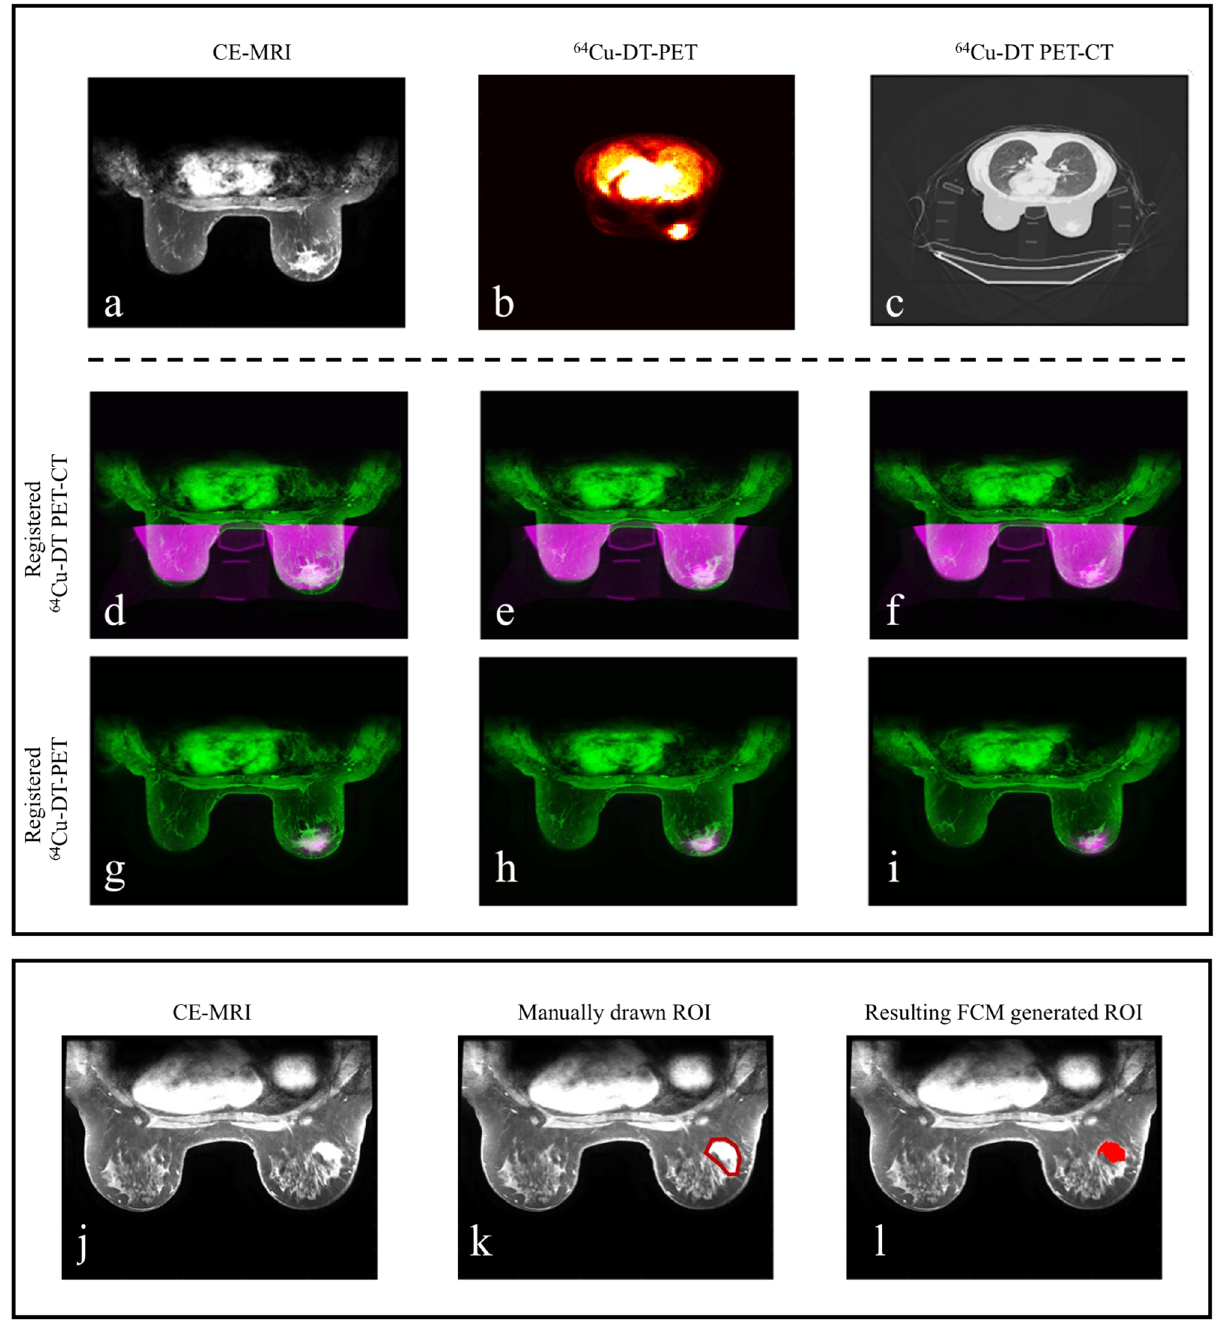
Figure 3. Example images of data processing for intra-scan registration of PET data to MRI data (upper panel) and generation of tumor ROIs (lower panel). Upper panel, deformable intra-scan registration for PET data to MRI data. Note that these images were all acquired in the prone position as opposed to the usual supine position using our novel breast support device (see text for details). The top row depicts a central slice for patient 1 at baseline for the CE-MRI ( a ), 64 Cu-DT-PET ( b ), and the 64 Cu-DT PET-CT ( c ). After the CT data is trimmed to only include breast tissue (i.e., the chest cavity and breast support was removed from the original images), the CT images were registered to the CE-MRI data using a fully deformable registration algorithm. ( d – i ) depict the resulting overlap between the CE-MRI data and registered CT-PET data for three central slices (green represents the CE-MRI data and pink represents the cropped 64 Cu-DT PET-CT and 64 Cu-DT-PET for ( d – f ) and ( g – i ), respectively). Lower panel, example images for generating tumor ROIs from CE-MRI data using the FCM method (patient 2). ( j ) Depicts a central slice of the CE-MRI data. ( k ) Shows a manually drawn, conservative ROI (red) on the CE-MRI data. ( l ) Depicts the FCM generated ROI